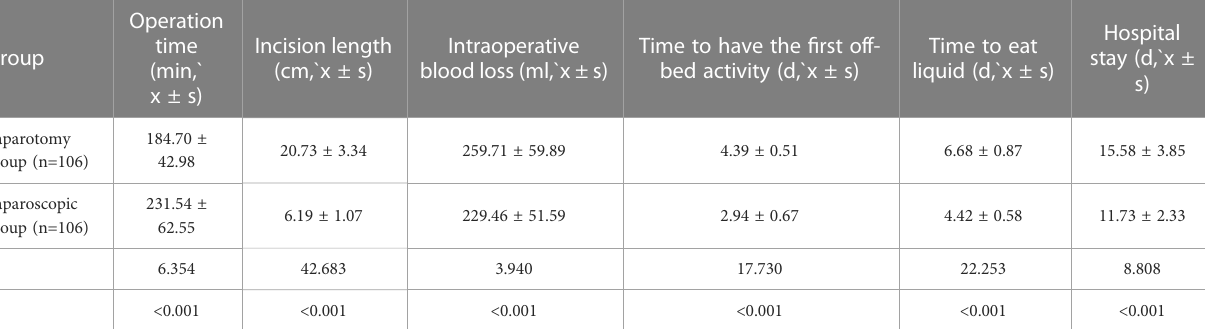
TABLE 2 Comparison of related perioperative indexes between the two groups.